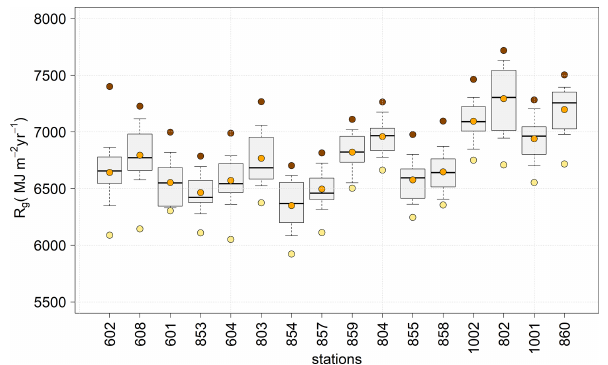
Figure 11. Statistical distribution of annual R g (MJm − 2 yr − 1 ) time series at each of the selected stations over the study area. The box shows 50% of the data, delimited by Q1 (lower) and Q3 (up- per); the solid line represents the median; and whiskers show 10th and 90th percentiles. Brown, orange, and yellow dots represent an- nual maximum, mean, and minimum time series value. Stations are sorted by increasing altitude from left to